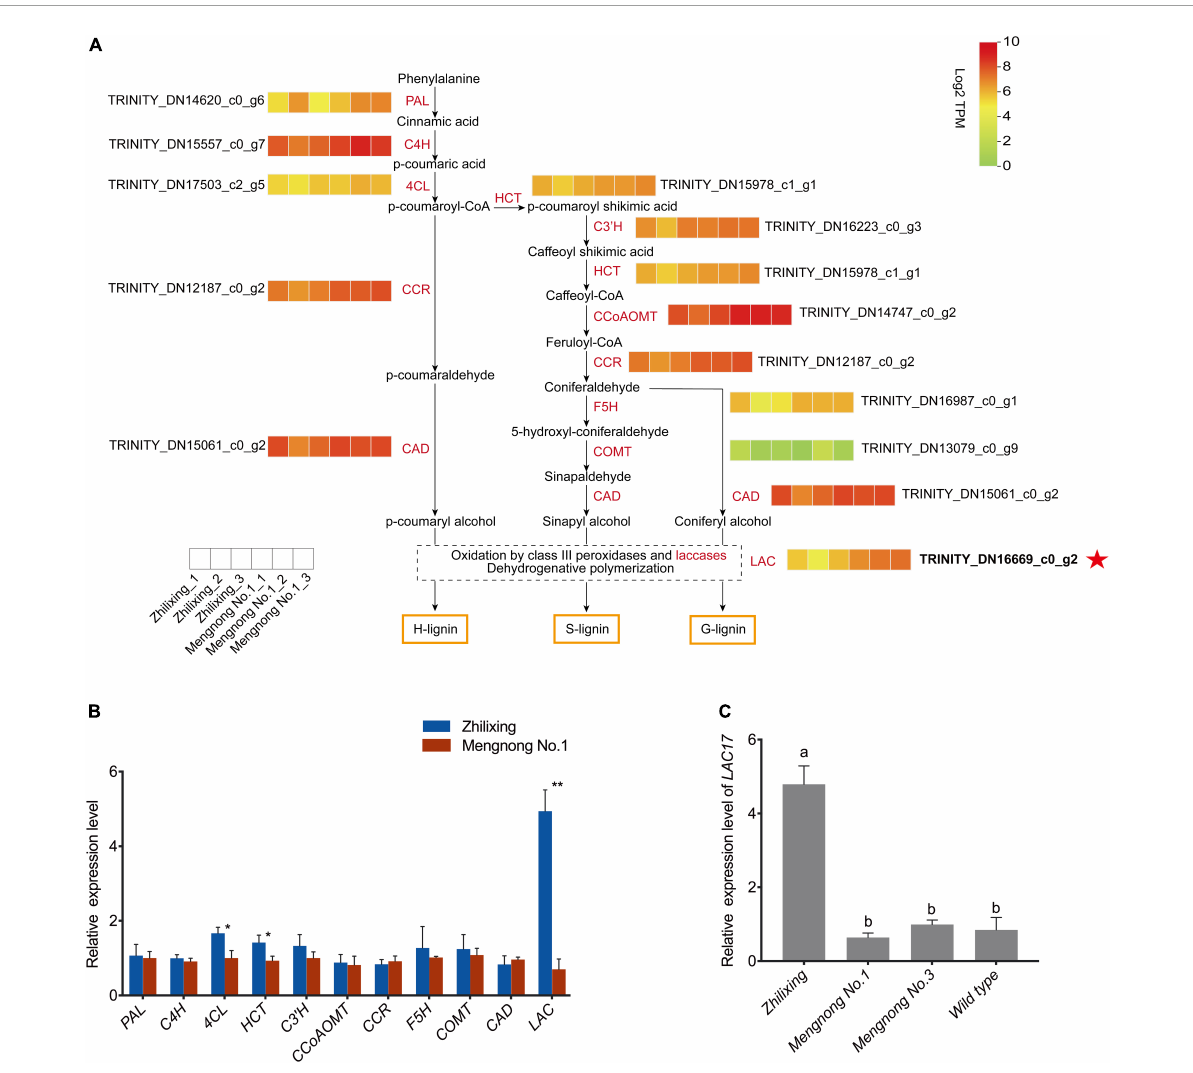
FIGURE4 Identification of key gene expression in the lignin synthesis pathway of erect and prostrate stems of M. ruthenica . (A) Heat map showing genes expression profiles in the lignin biosynthesis pathway. For each heatmap, each small box represents the expression level of a biological sample at the transcription level with TPM values increasing from green to red. Each cultivar is represented by three biological replicates. (B) Expression of lignin biosynthesis related unigenes of the two M. ruthenica cultivars by PCR analysis. The gene ID is the same as that shown in the heatmap. The expression level in Mengnong No.1 was set to 1. MrActin was used as the internal control. Values are means ± S.D. of three biological replicates. Asterisks indicate significant differences determined by Student’s t -tests (** p < 0.01, * P < 0.05). (C) Expression of monolignol polymerization gene LAC17 in the erect and prostrate stems. Different lowercase letters indicate highly significant differences ( p <